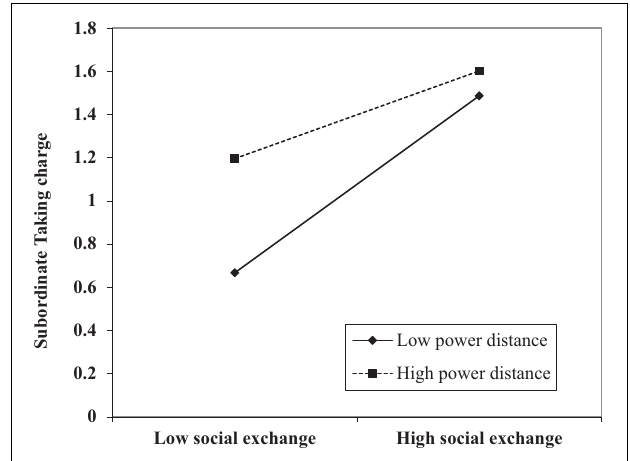
FIGURE 2 | Interaction plot of social exchange and power distance on taking